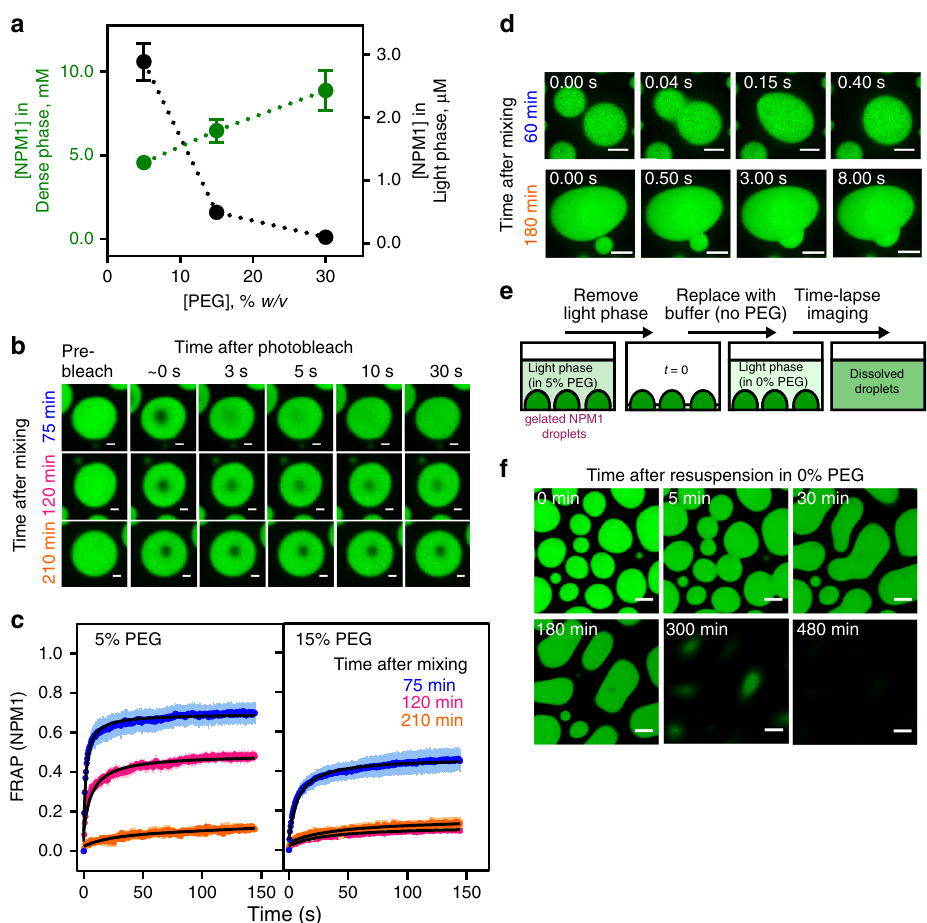
Fig. 3 Homotypic NPM1 droplets undergo reversible aging. a NPM1 concentrations measured within the dense (green, n ≥ 343 droplets) and light (black, n = 6) phases prepared in the presence of 5%, 15% and 30% PEG (see Methods). Values represent mean ± s.d. b Confocal microscopy images of NPM1- A488 droplets photobleached at t = 75 min (top row), 120 min (middle row), and 210 min (bottom row) after mixing 20 μ M NPM1 with 5% PEG in 10 mM Tris, 150 mM NaCl, 2 mM DTT, pH 7.5 buffer; scale bar = 1 μ m. c FRAP recovery curves of NPM1-A488 in 20 μ M NPM1 droplets at t = 75 min (blue), 120 min (magenta), and 210 min (orange) after droplet formation in the presence of 5% PEG (left panel) and 15% PEG (right panel). Values represent mean ± s. d. for n ≥ 8 droplets. Under both crowding agent conditions, the fraction of NPM1 that recovered decreased at the later time points after mixing; ROI = 1 µ m circular area in the center of the droplet. d Time-lapse fl uorescence microscopy images of fusion between NPM1-A488 droplets formed 60 min (top row) or 180 min (bottom row) after mixing in the presence of 5% PEG. Droplets fused rapidly after incubation for 60 min, but fusion was very slow after incubation for 180 min. e An illustration of the experimental scheme used to monitor dissolution of aged NPM1 droplets formed in 5% PEG upon removal of the crowding agent. Light phase (90% of the solution) was gently removed and replaced with the same volume of buffer lacking PEG. Droplet dissolution was monitored over time using confocal fl uorescence microscopy imaging. f Time-lapse imaging of aged droplets dissolving after removal of the